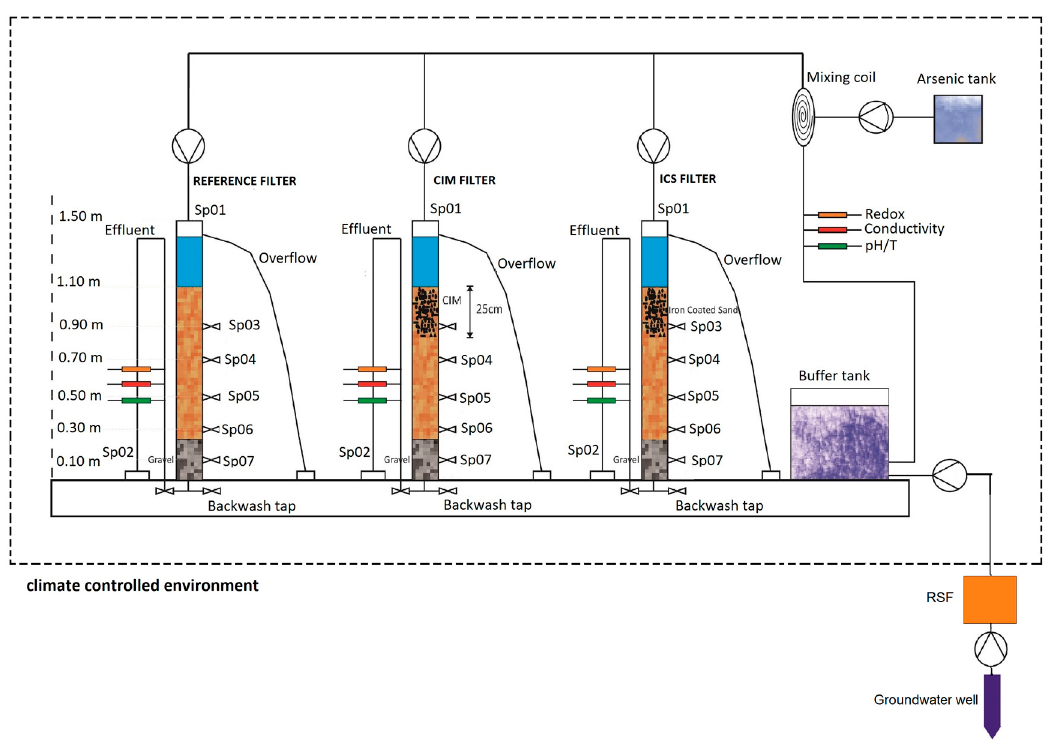
Figure 1. Experimental setup consisting of three pilot-scale slow-sand filters containing different filtration media: sand and gravel (reference filter); sand, gravel and corrosive iron matter (CIM); sand, gravel and iron-coated sand